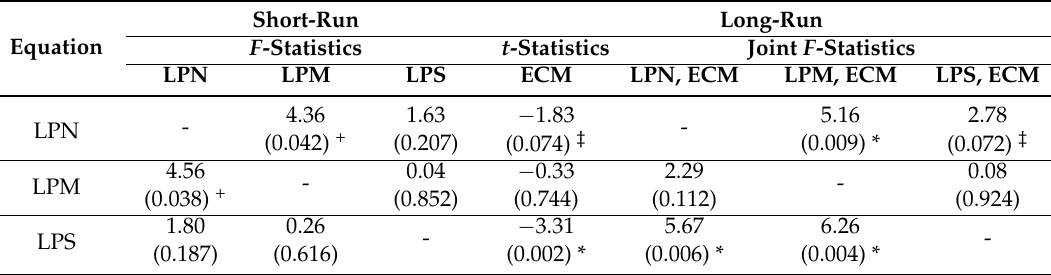
Table 9. VECM-based trivariate granger causality test.